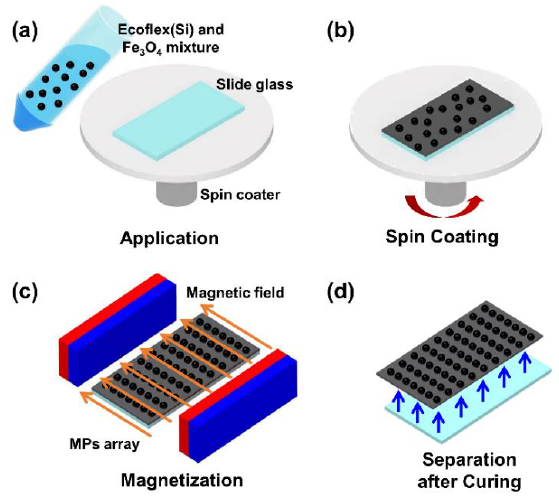
Figure 3. Schematic of the fabrication outline of a polymer actuator based on chained-magnetic-particle-embedded elastomer. ( a ) A composite was applied to the slide glass. ( b ) Samples were spin coated. ( c ) By exposing the silicon mixture to the placed permanent magnet, an array was formed by the magnetization of MPs inside. ( d ) After curing, the sample was separated from the slide glass.